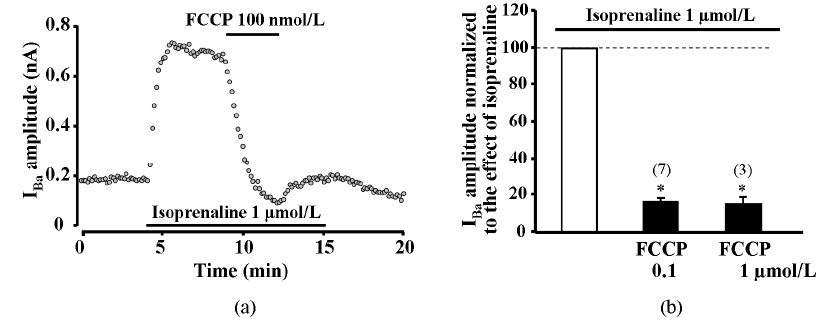
Figure 5. Effect of FCCP on isoprenaline stimulated Ba 2+ current through L-type calcium channels in human atrial myocytes. Only suppression of Ca 2+ channel current was registered during metabolic inhibition after equimolar substitution of extracellular Ca 2+ for Ba 2+ . ( a ) A typical experiment representing the effect of FCCP on I Ba in ISO-stimulated cells. ( b ) Peak amplitude of I Ba during exposure of ISO-stimulated human atrial cells to FCCP. Values are presented as means ± SEM for the number of cells indicated in parentheses. * p < 0.05 versus ISO alone.